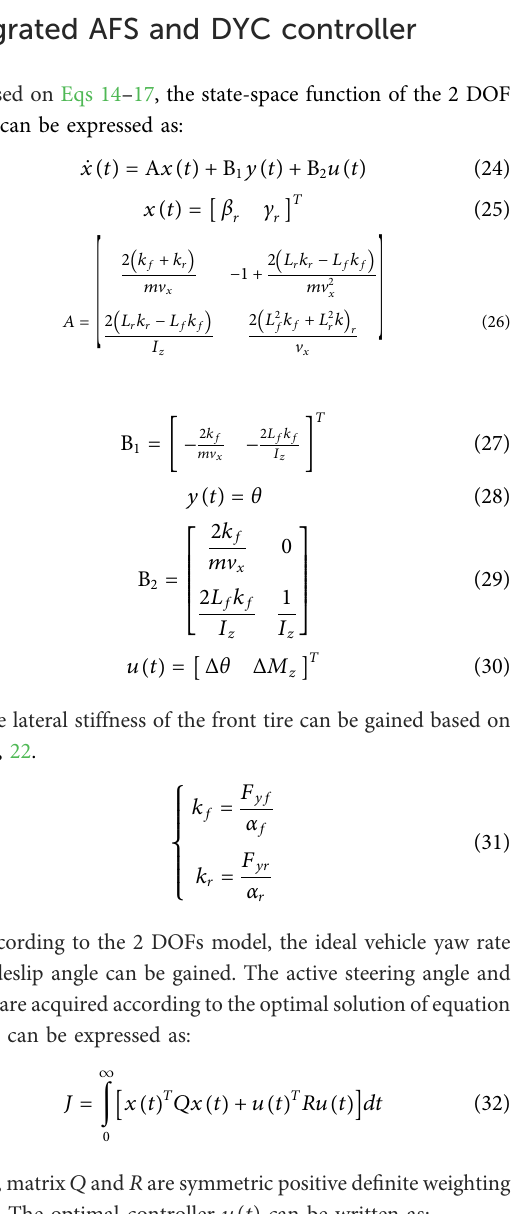
brush tire. The main goal of the control system is to make the actual yaw rate, γ , to follow the ideal yaw rate, γ , generated by the r reference model and maintain the vehicle sideslip angle, β , in a certain range to prevent the vehicle from spinning. According to the comparison of the ideal and actual yaw rate and vehicle sideslip angle, the controller generates the active steering angle, Δ θ , and yaw moment, Δ M z . The yaw moment is converted to driving torque on the four wheel motors.